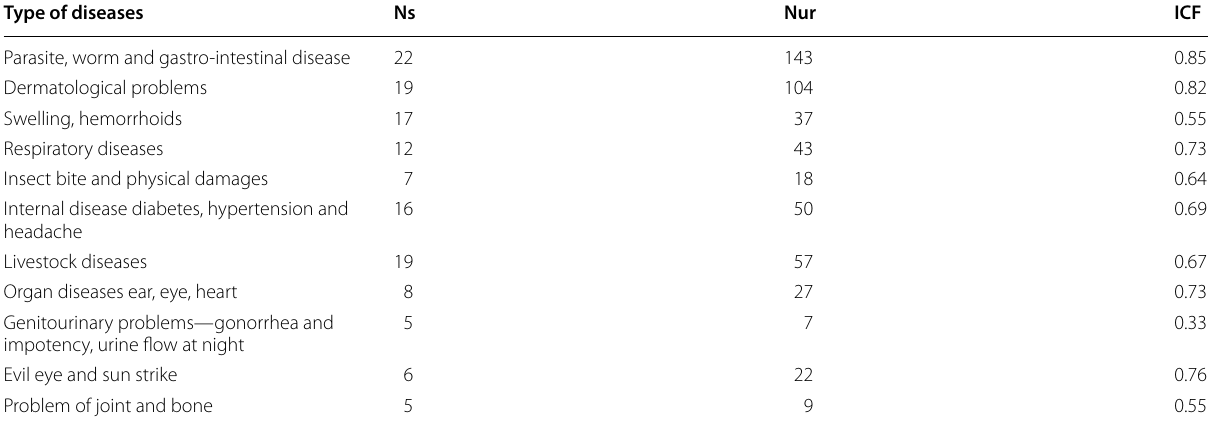
Table 5 ICF of the given diseases category